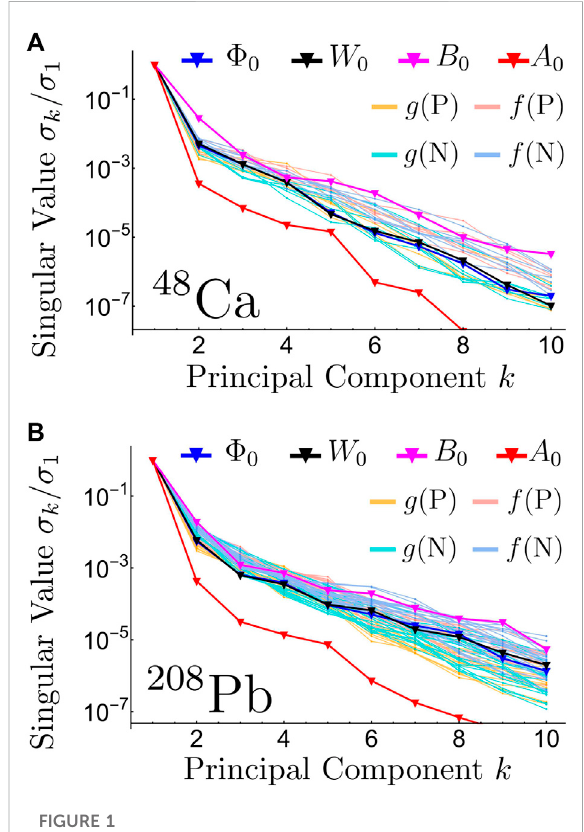
FIGURE 1 Normalized singular values σ k / σ 1 for the fi elds Φ 0 ( r ), W 0 ( r ), B 0 ( r ), and A 0 ( r ), and the single particle wave functions of the upper g n κ ( r ) and lower f n κ ( r ) components for 48 Ca (A) and 208 Pb (B) . The single particle proton levels are denoted as g ( P ) and f ( P ) for the upper and lower components, respectively, while the single particle neutron levels are denoted as g (N) and f (N) for the upper and lower components, respectively. There are six proton levels and seven neutron levels for 48 Ca (A) , while for 208 Pb there are sixteen proton levels and twenty-two neutron